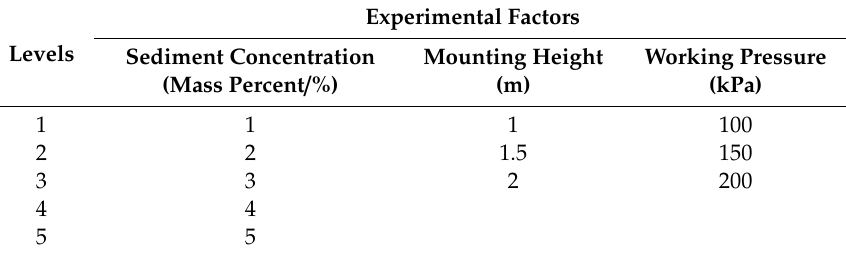
Figure 2. Suspended sediment concentration in the Yellow River. Table 1. Experimental factors and levels.